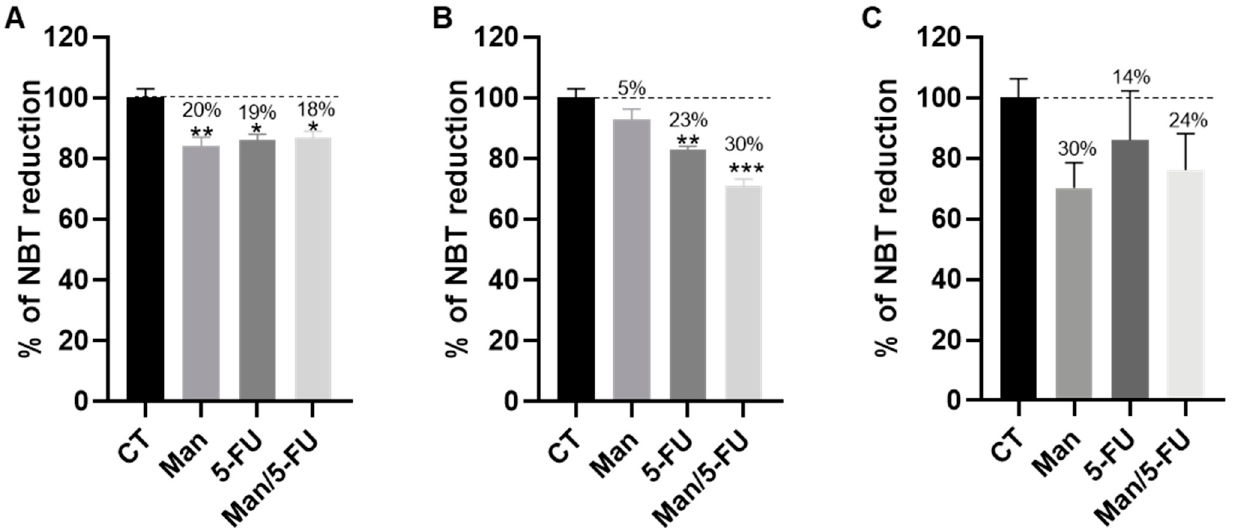
Figure 6. Effect of mannose and 5-FU single and combination treatments on reactive oxygen species (ROS) production in human CRC cells. ( A ) HCT116, ( B ) HCT116 p53 − / − , and ( C ) HCT116-5FUR cells were treated with mannose (man 50 mM) and/or 5-FU (5 µ M) for 24 h. ROS levels represent an average of three independent experiments ± SEM. * p < 0.05, ** p < 0.01, and *** p < 0.001 are considered statistically signi fi cant.